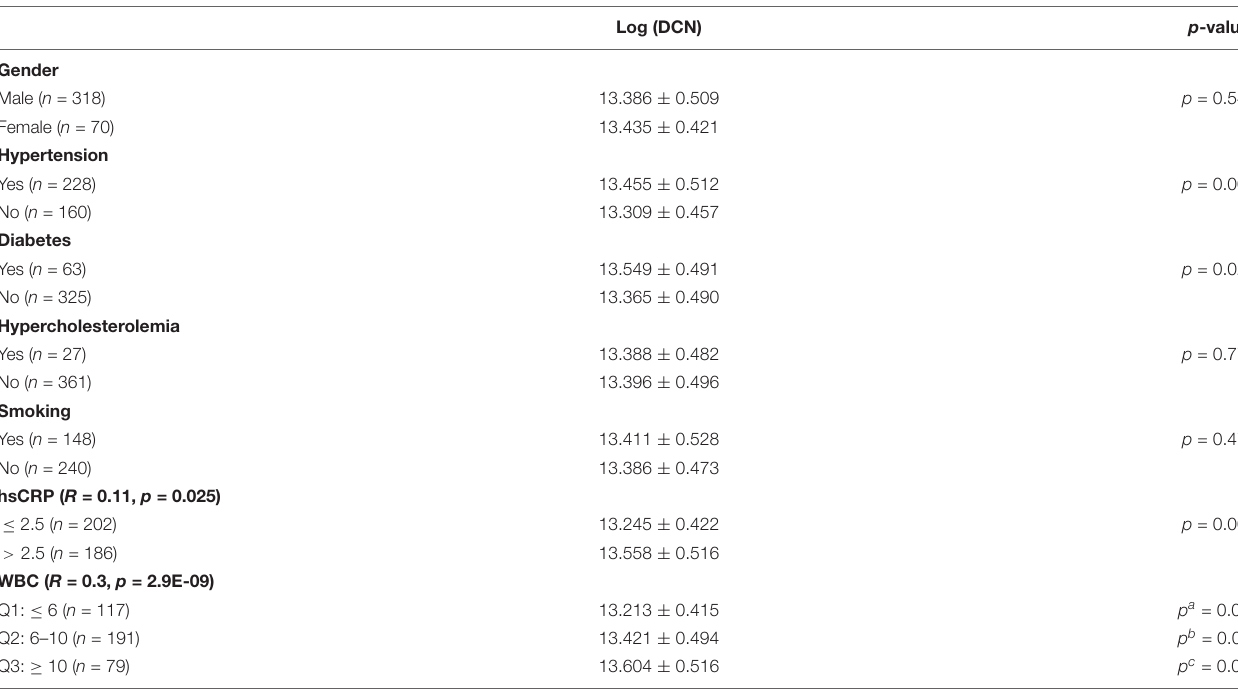
TABLE 2 | Association of cardiovascular risk factors with DCN